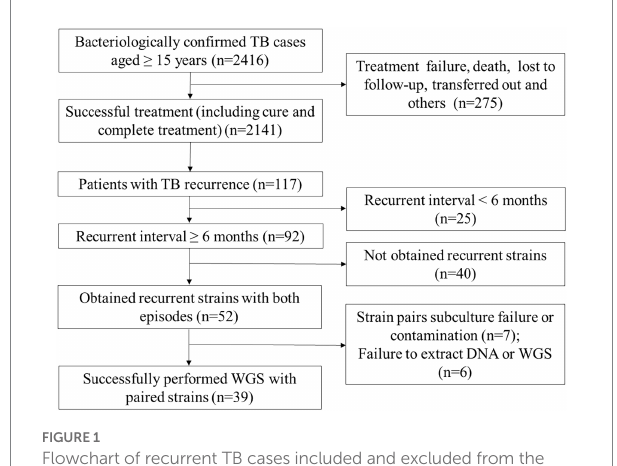
FIGURE 1 Flowchart of recurrent TB cases included and excluded from the